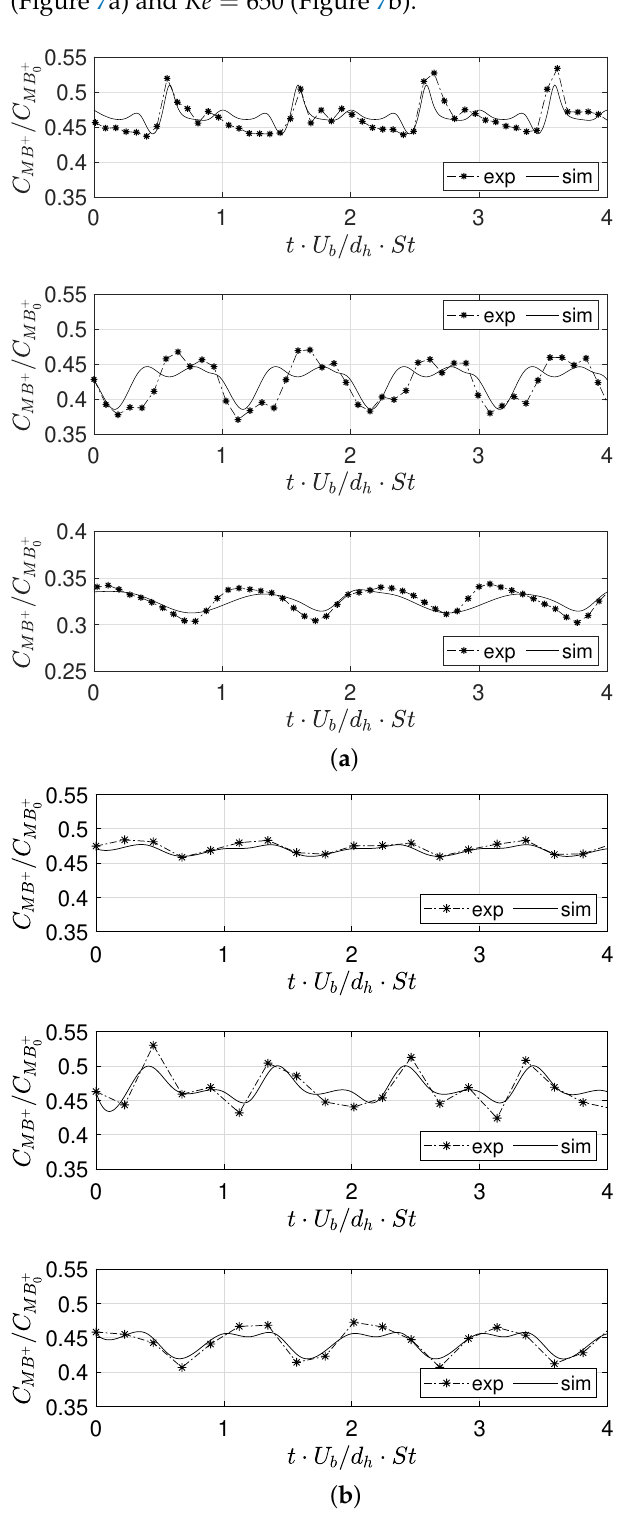
Figure 7 compares experimental and numerical temporal signals of the average MB + concentration, which is made non-dimensional with respect to the inlet MB + concentration, at the Y = − 2, Y = − 7.5 and Y = − 25 cross-sections (from top to bottom) and for Re = 320 (Figure 7a) and Re = 650 (Figure 7b).